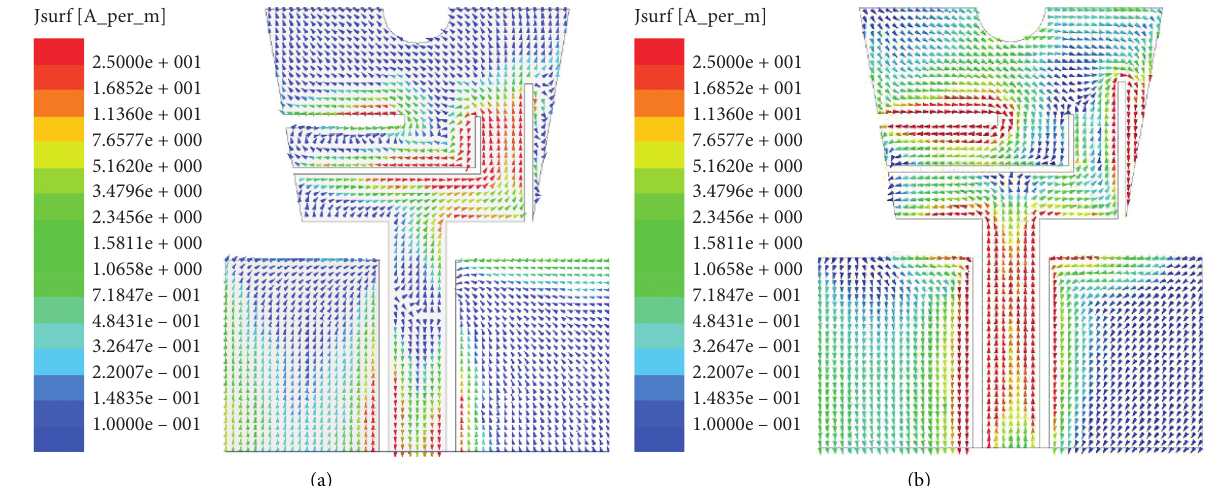
Figure 3: Surface current distributions at (a) 2.45GHz and (b) 5.5GHz.